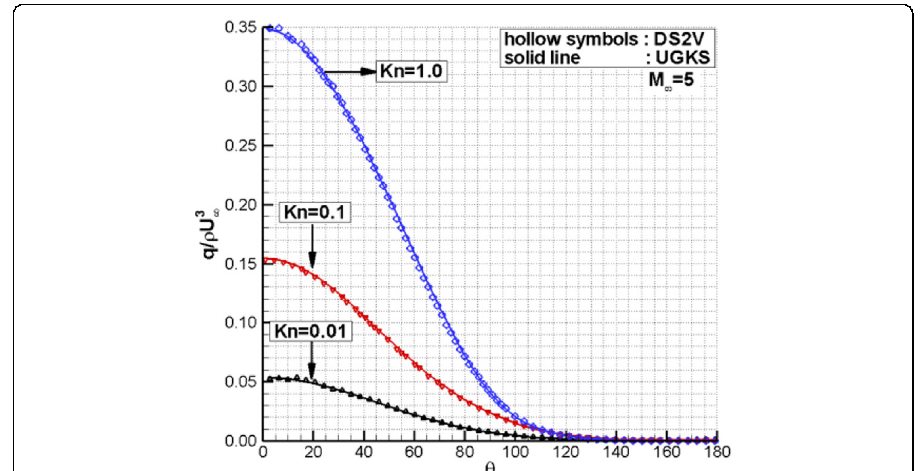
Fig. 17 Heat flux distributions on the cylinder surface at M = 5